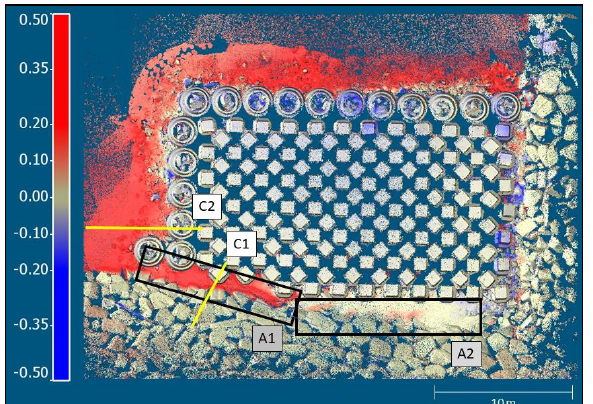
Figure 8. April / November differences [m]